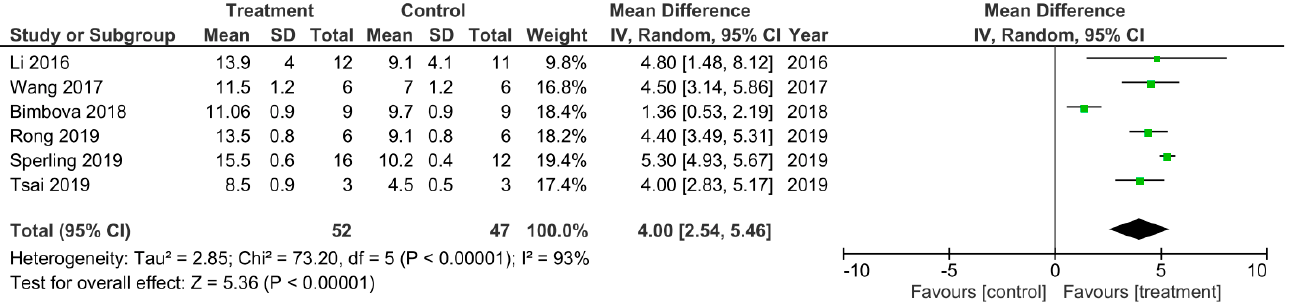
Figure 4. A meta-analysis for the effect of single treatments on the improvement of BBB scores analyzed at 42 days after spinal cord injury in six studies [19,32,46,48,51,53].